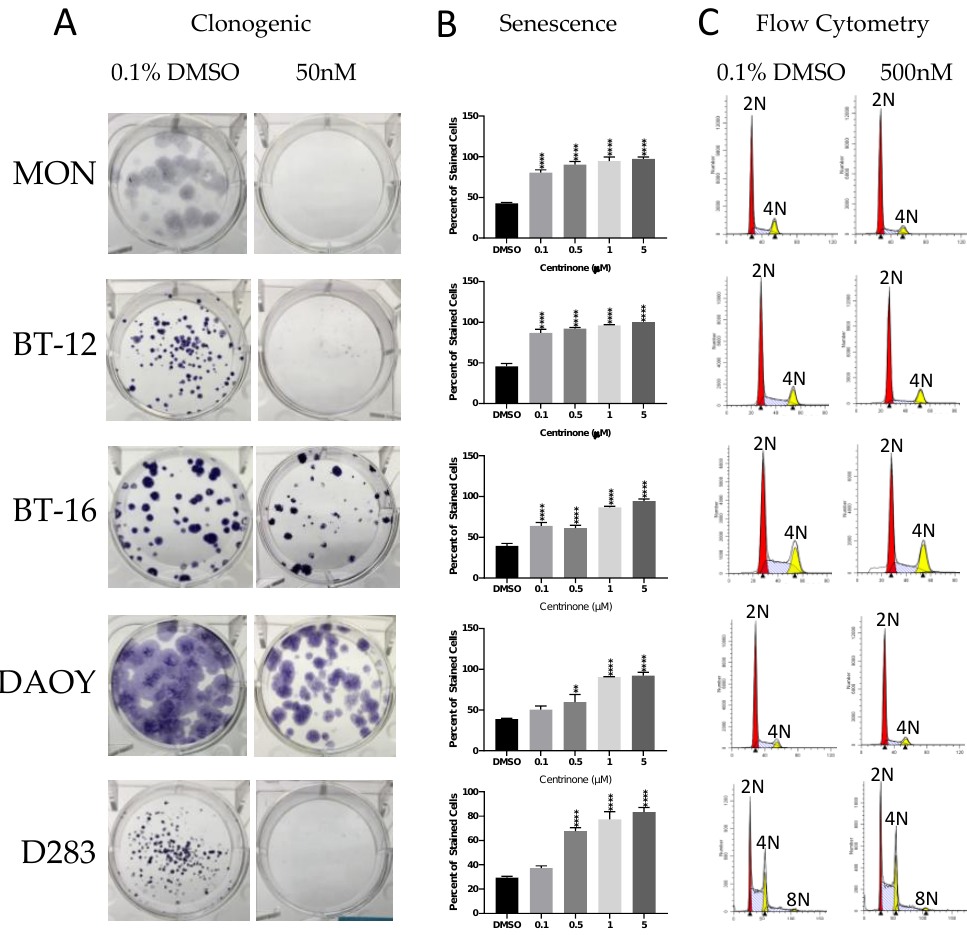
e ffi cient PLK4 inhibitory e ff ect inducing a phenotype consistent with PLK4 inhibition in EBT cells. Key features suggest a potential for low cardiotoxicity or drug–drug interaction risk.